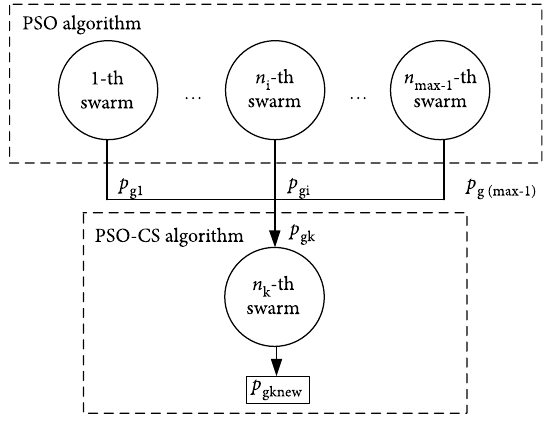
Figure 6: Schematic of an optimization